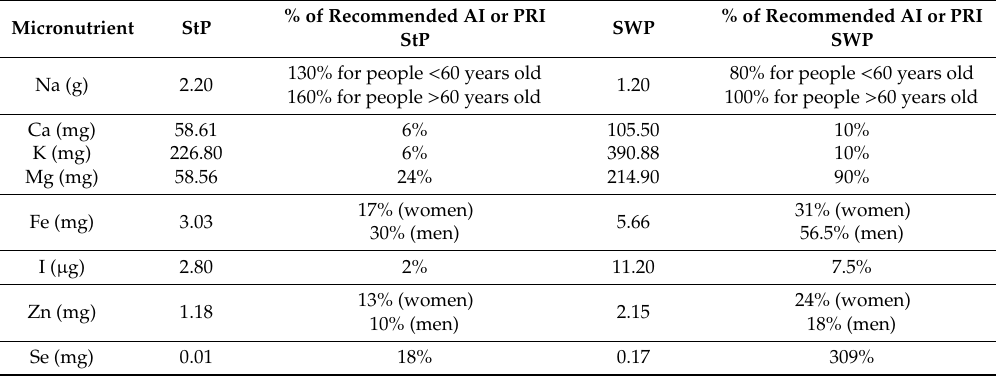
Table 2. Nutritional characteristics of the